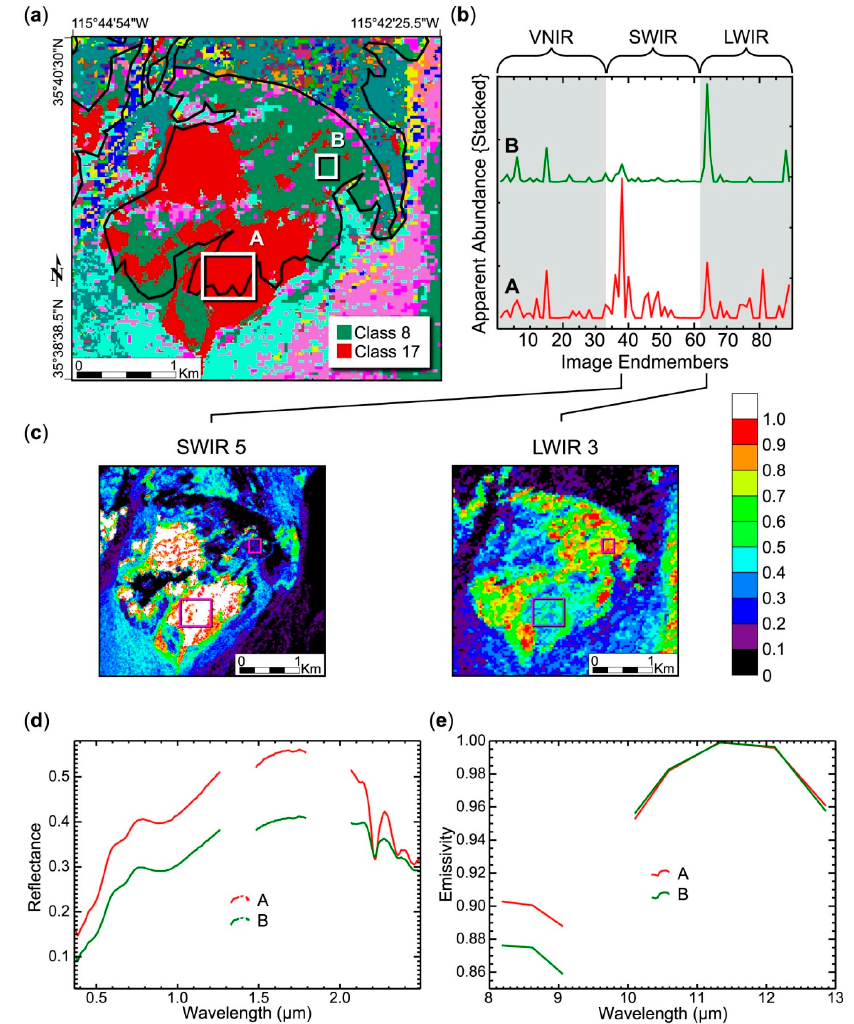
Figure 13. Examination of individual wavelength range results incorporated in the full-range characterization of a siliciclastic rock unit: ( a ) subset of the integrated classification map with outlines of general surface units and regions of interest corresponding to subsequent plots; ( b ) graph of mean endmember abundance values for selected regions of interest, offset for clarity; ( c ) abundance distribution images for notable endmembers; ( d ) mean visible to near infrared (VNIR) and shortwave infrared (SWIR) spectra of selected regions of interest; ( e ) mean longwave infrared (LWIR) spectra of selected regions of interest.